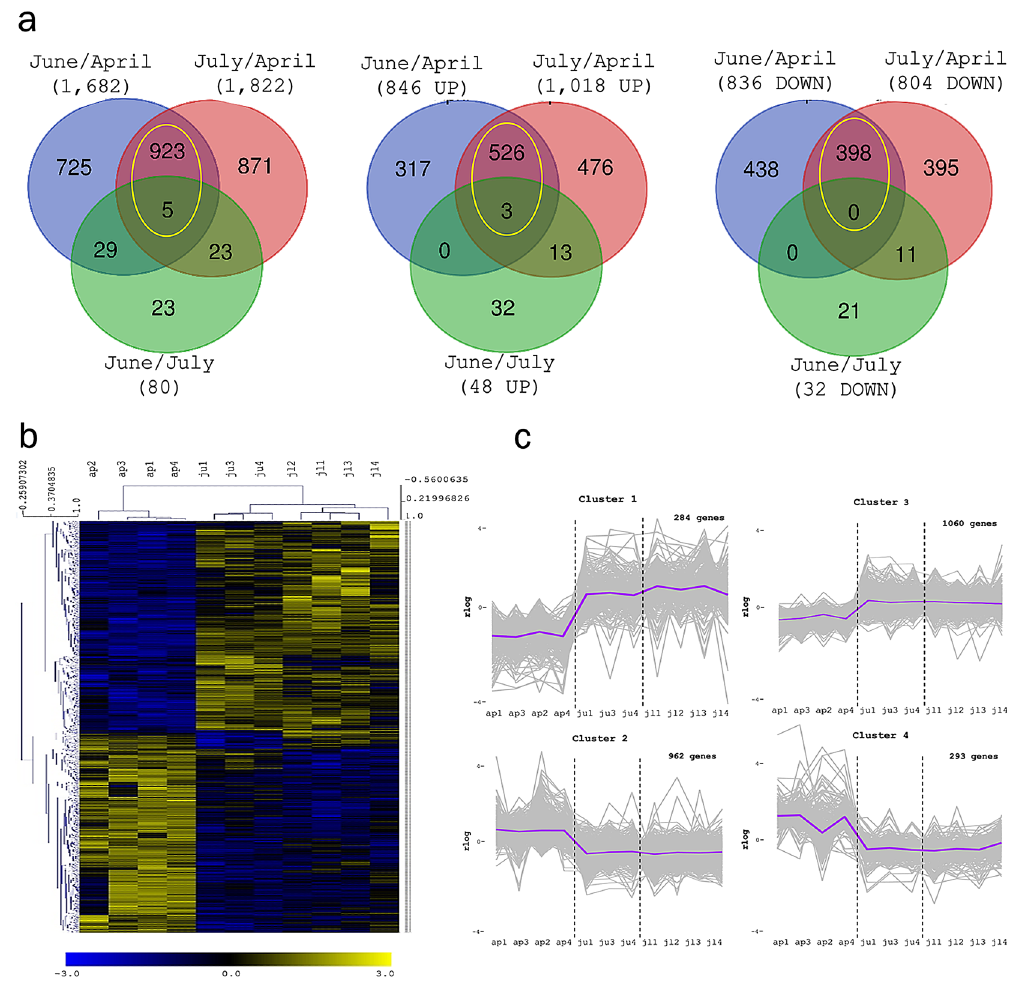
Figure 3. Differential expression along the cork growing season. ( a ) Venn diagrams showing DEGs, upregulated (UP) and downregulated (DOWN), between June/April, July/April and June/July. The yellow circle includes the genes identified in both June/April and July/April comparisons. ( b ) Hierarchical clustering of cork samples based on the expression of DEG along the growing season. C. K-means clusters of co-expressed genes in April, June and July. Cluster 1 and 3 contain genes downregulated in April and upregulated in June and July, whereas cluster 2 and 4 showed the opposite pattern containing genes upregulated in April and downregulated in June and